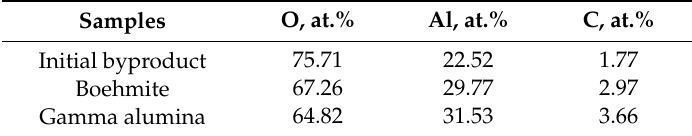
Table 1. Chemical composition of the precursor (Al(OH) 3 ) and calcined materials. Samples O, at.% Al,